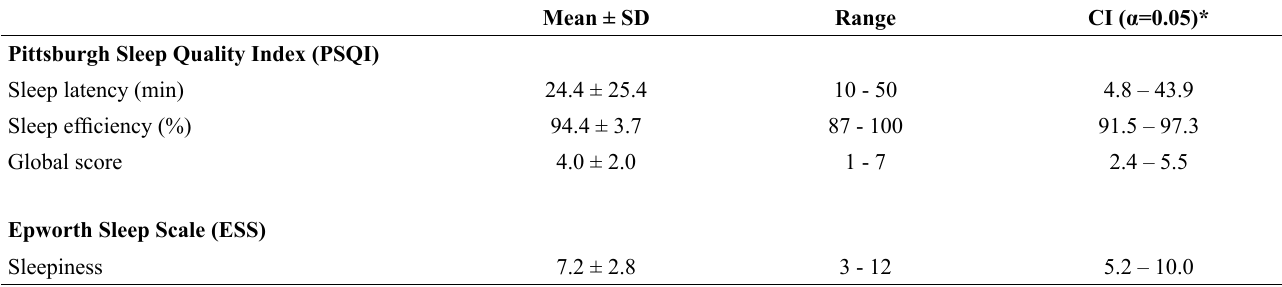
Table 3. Pittsburgh Sleep Quality Index (PSQI) and Epworth Sleep Scale (ESS) results of the slalom kayakers.